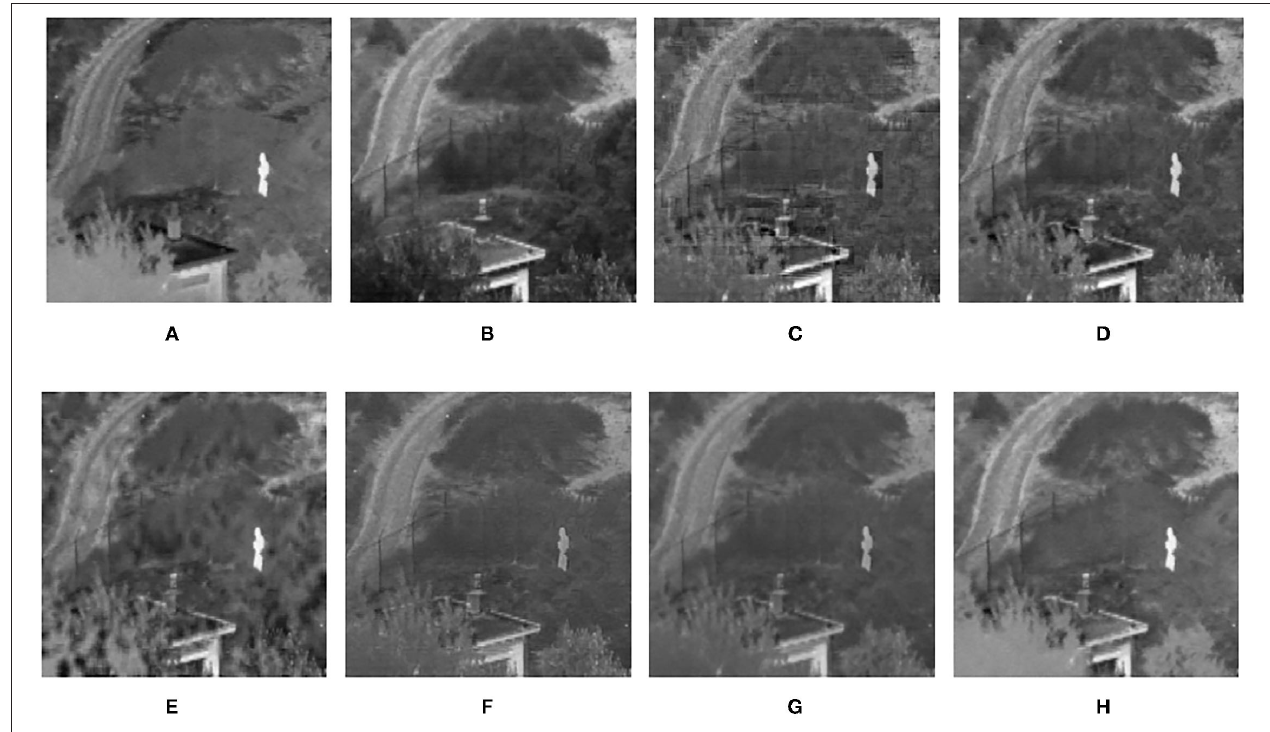
FIGURE 10 | Comparison experimental results of infrared and visible images. (A) original image (infrared image); (B) original image (visible image); (C) DWT; (D) LP; (E) SR; (F) DTCWT-SR; (G) VGG; (H) MPS.